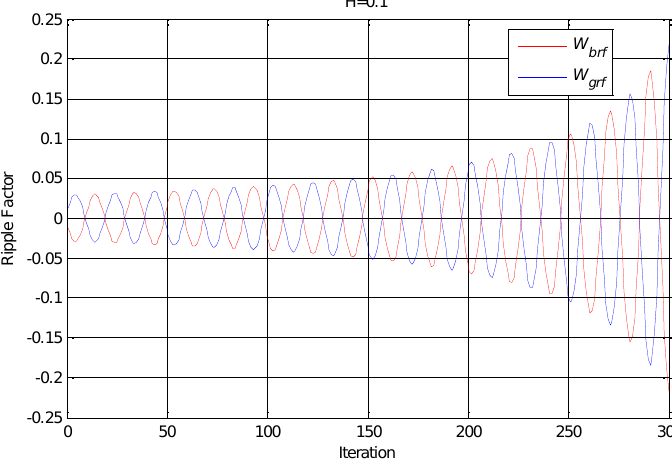
Figure 2. Influenced characteristics of a ripple wave at the ripple constant value, H = 0.1.